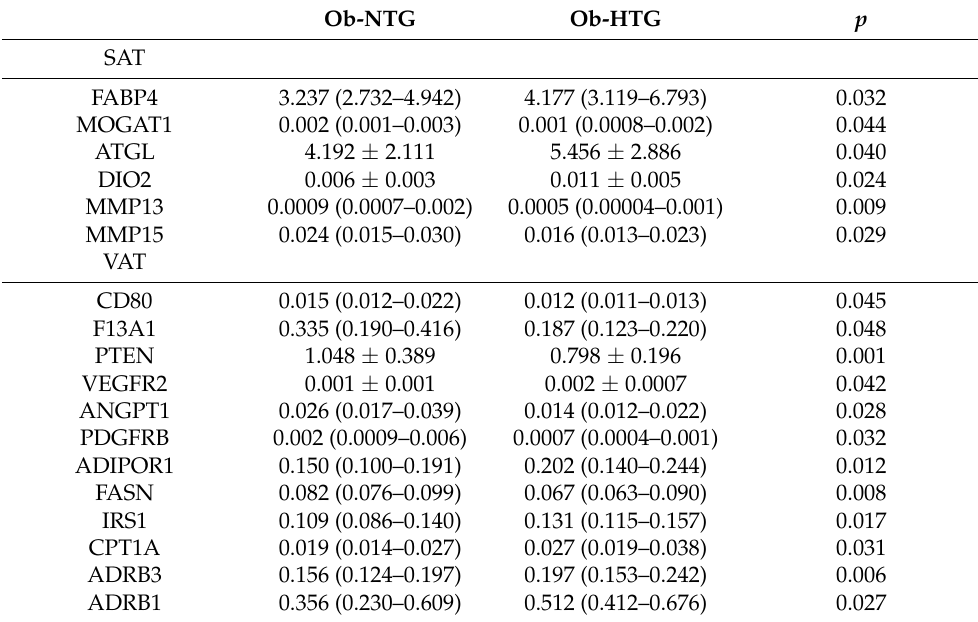
Table 2. Differently expressed genes in adipose tissue between Ob-NTG and Ob-HTG subjects.